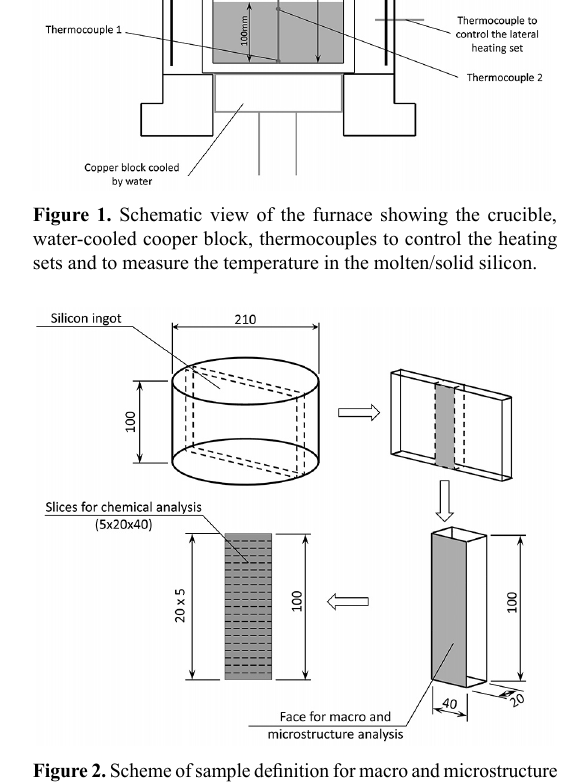
Table 1. Partition coefficient between solid and liquid for solute element i ( k solubility of element i in solid Si (SL) 4 ; and the concentration of the main metallic impurities in the MG-Si ( C